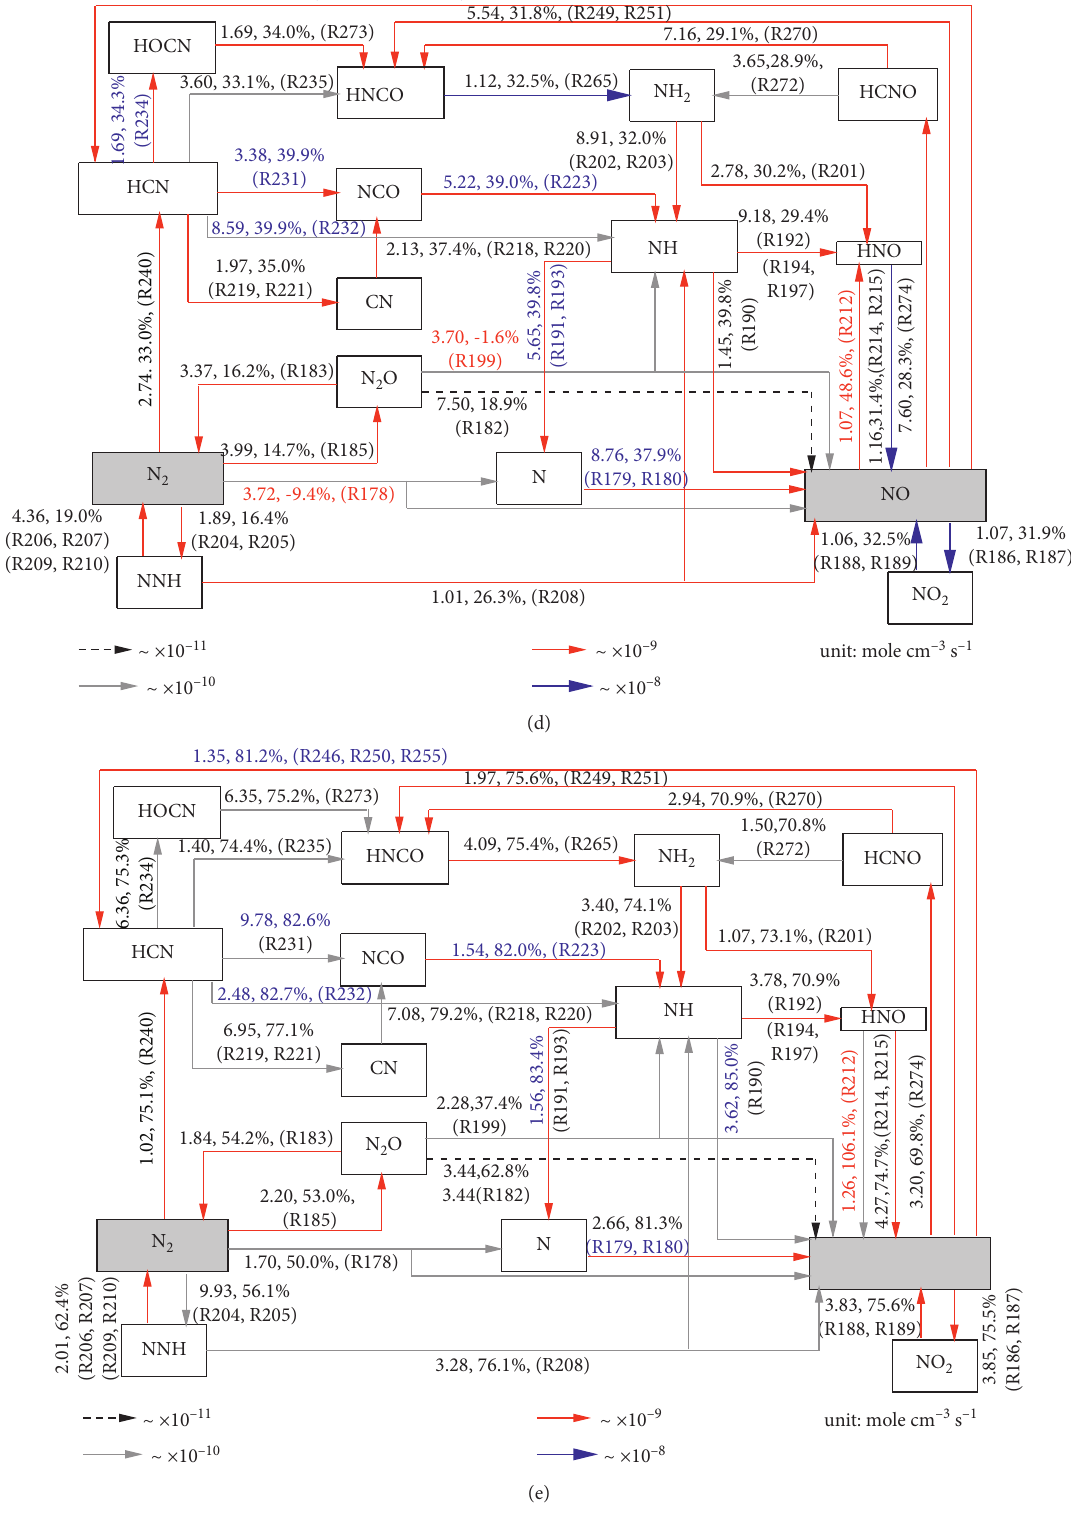
Figure 11: NO formation pathways for (a) no dilution (Case 1). (b) 20% CO (d) 20% H 2 O dilution in fuel (Case 3). (e) 20% H 2 O dilution in air (Case